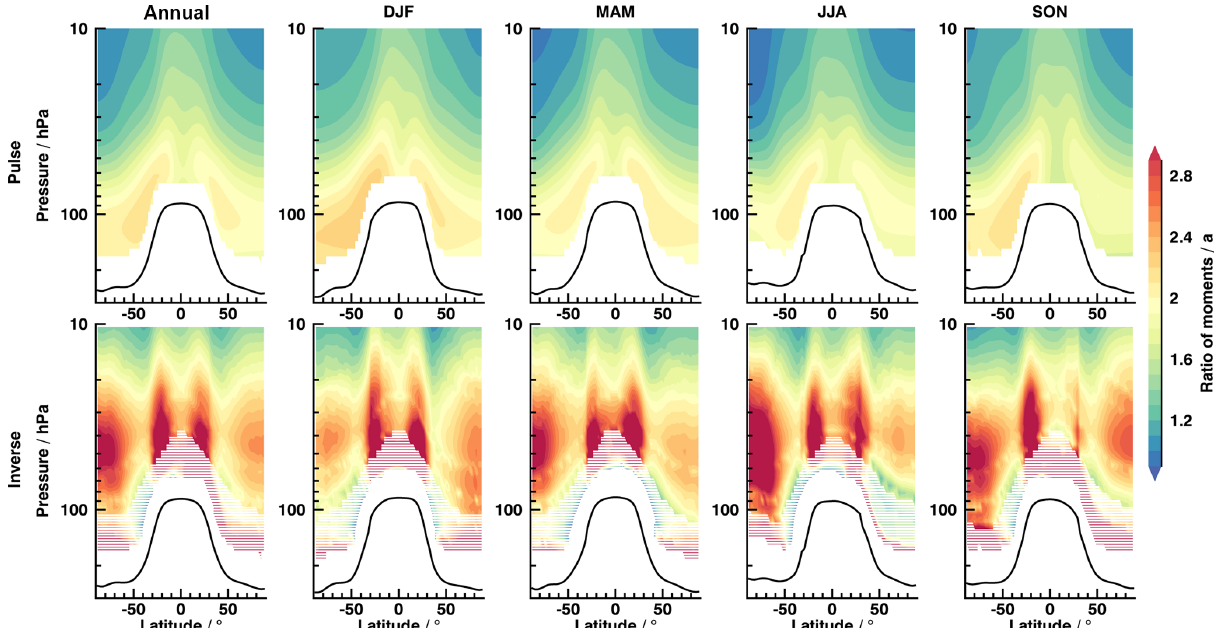
Figure 10. Absolute annual and seasonal ratio of moments as global cross section for pulse (top row) and inverse spectra (bottom row). Again, the white dashed area represents data below clock mean AoA of 1.5